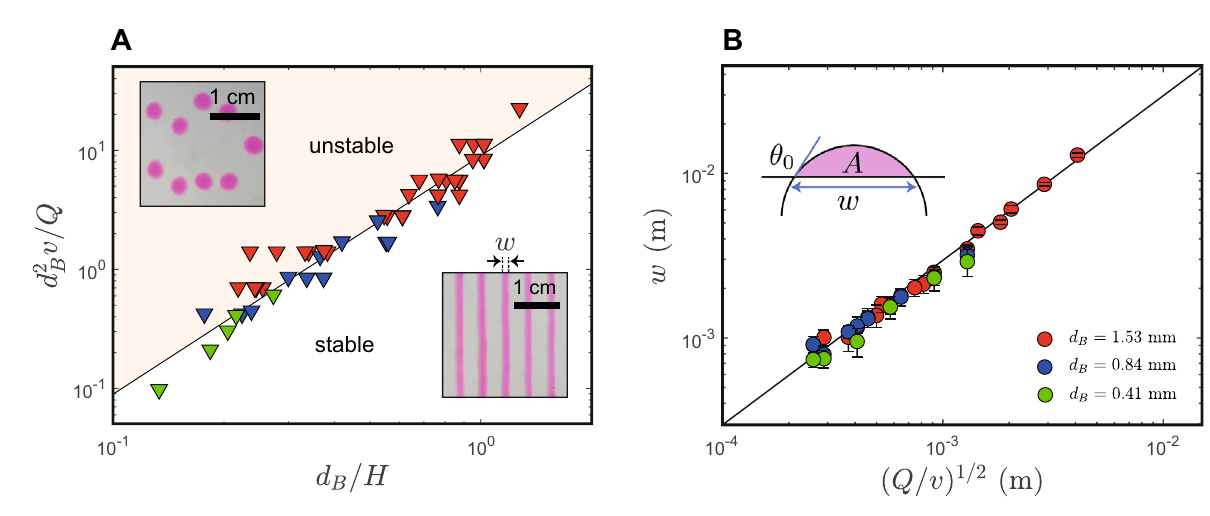
Figure 2. ( A ) Stability map of ‘printability’ separating continuous/stable from discontinuous/unstable printing (see inserts). The solid line is an guide scaling with a power 2; colours as in ( B ). ( B ) Footprint w of the deposit A , the volume per unit of length of deposit. The solid line is a fit, upon stable printing as a function Q / v ≡ 0.1 ) fits with see text, showing a linear relationship between footprint w and ( Q / v ) 1 / 2 ; the prefactor ( 3.0 ± trigonometry. d B is the internal diameter of the